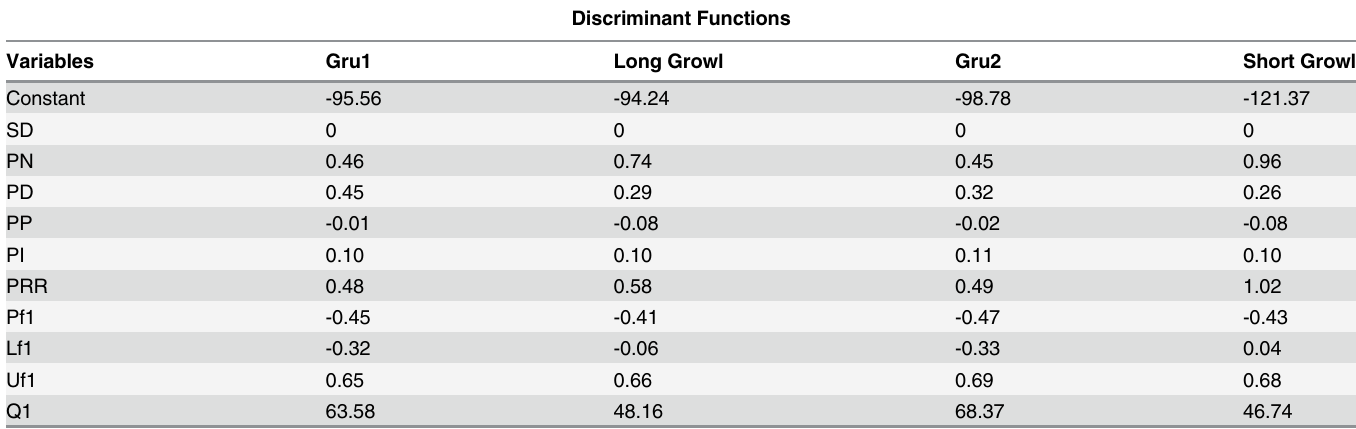
Table 2. Linear discriminant functions for the validation of sound type classification. SD = sound duration; PN = number of pulses; PD = pulse dura- tion; PP = pulse period; PI = pulse interval; PRR = pulse repetition rate; Pf = peak frequency; Lf = lower frequency; Uf = upper frequency 3dBBW = 3 dB band- width; Q = damping coefficient.